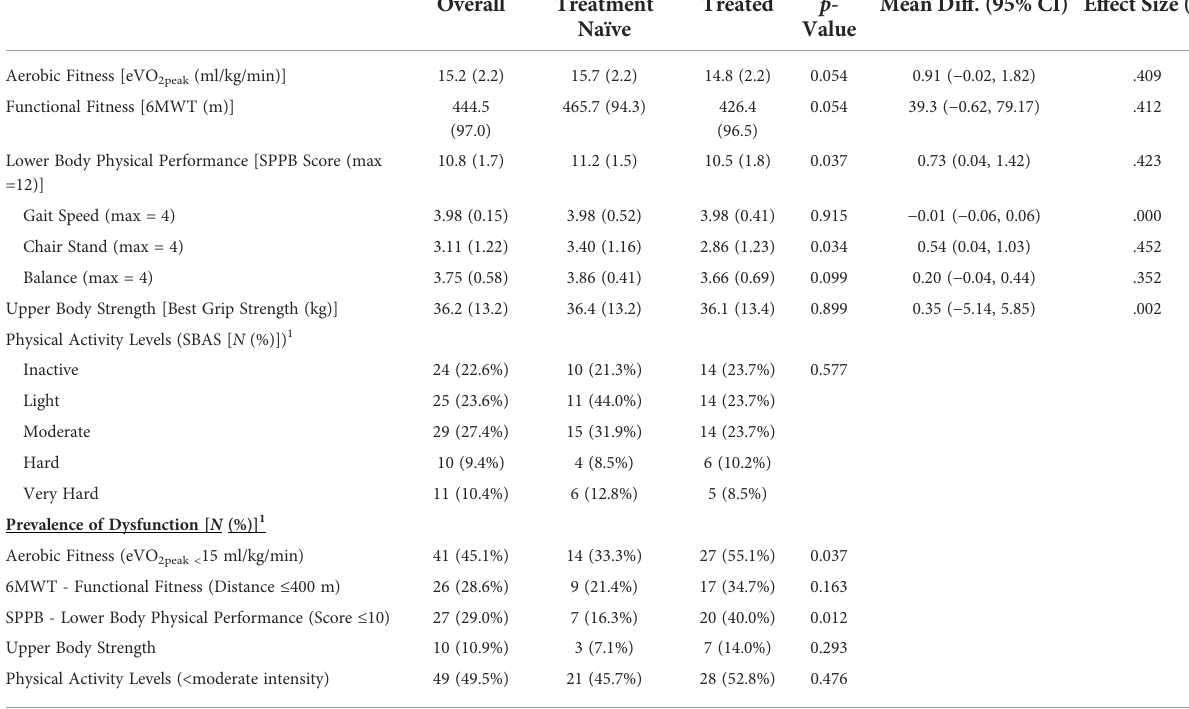
TABLE 2 Physical fi tness, function, and activity level characteristics and prevalence of dysfunctions. Overall Treatment